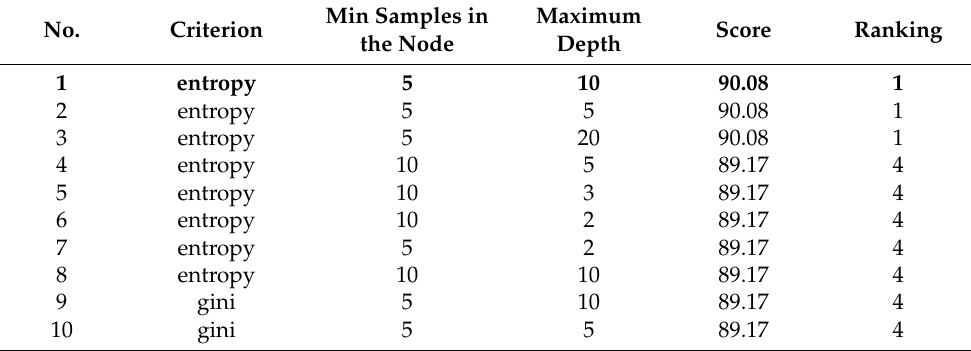
Table 4. Decision Tree hyperparameter-tuning results.